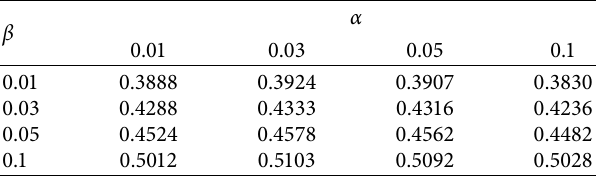
Table 5: Ratio of sample size required for the SPRTand N − P test (%). β